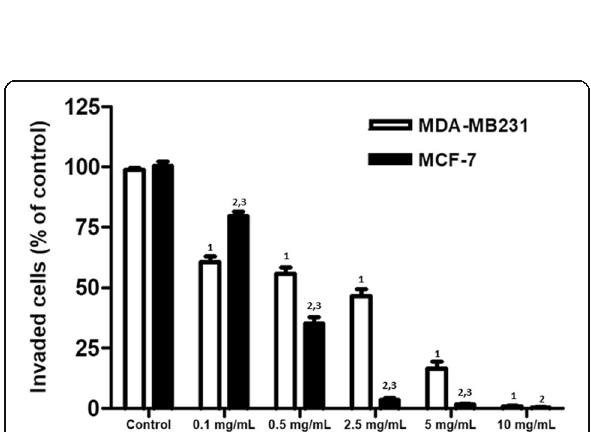
Fig. 2 Effects of T33 on the invasive capacity of MDA-MB231 and MCF-7 cells. Transwell migration assay was performed in MDA- MB231 and MCF-7 cells after treatment with different concentrations of T33 for 24 h. Similar results were observed in triplicate experiments. The superscripts 1, 2, and 3 refer to significant differences ( P < 0.05) from the MDA-MB231 control, MCF-7 control and MDA-MB231,